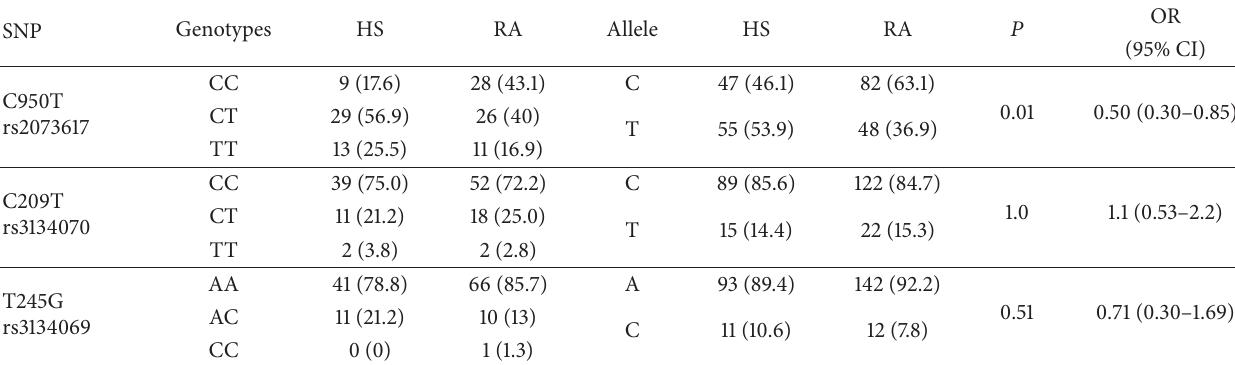
Table 3: Genotype and allele frequencies of polymorphisms in the TNFRSF11B (OPG) gene in healthy subjects and rheumatoid arthritis (RA) patients.